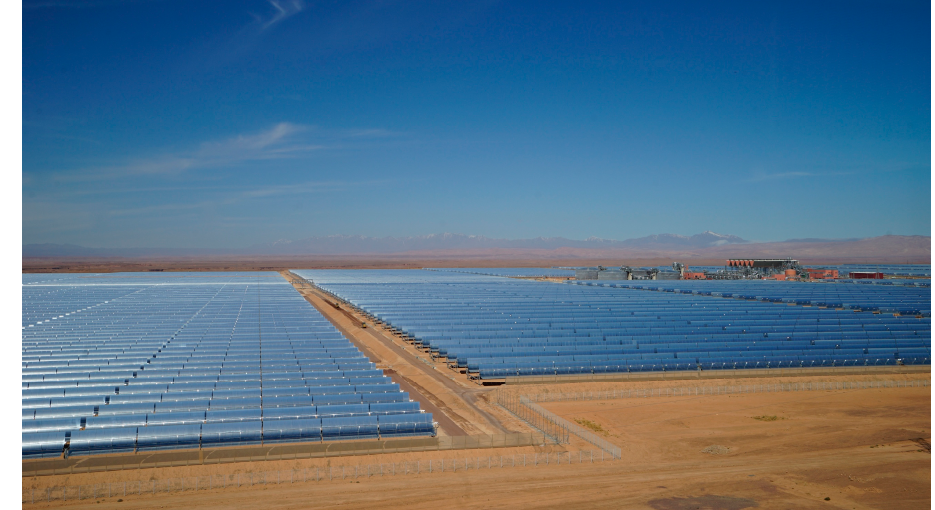
Figure 2. Noor Ouarzazate Solar Project complex (Photo: Sarah Ryser 2018).